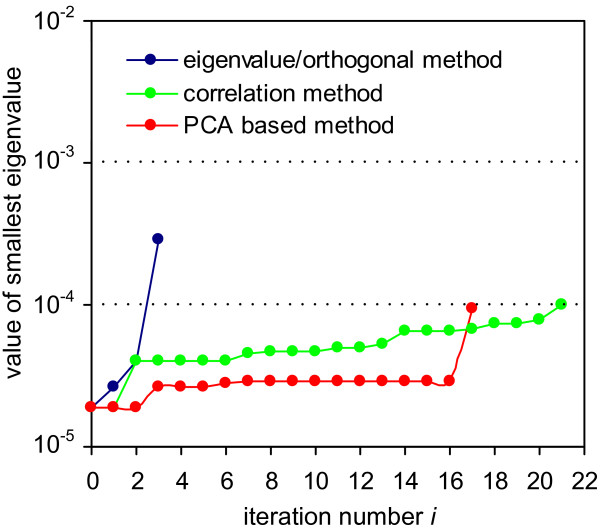
Results of the methods applied to the NF-κB model.